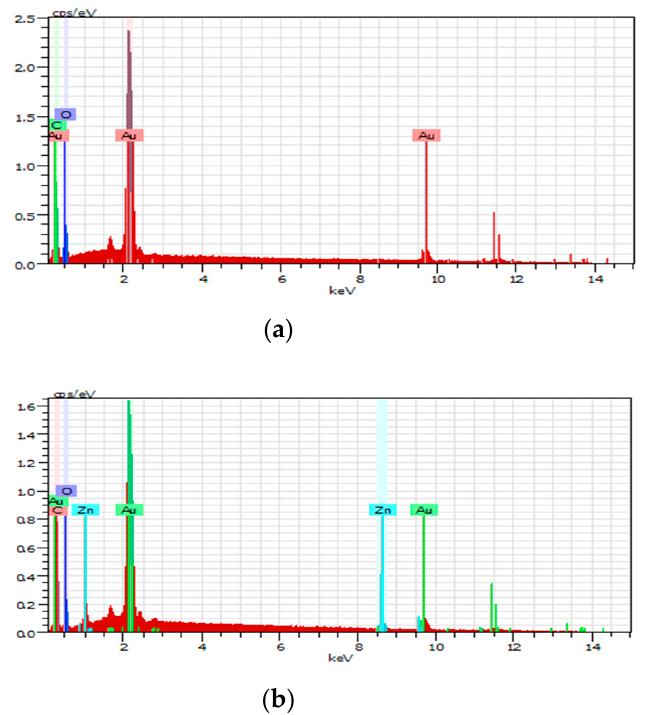
Figure 6. EDX spectra of the ( a ) pristine wood flour and ( b ) as-prepared superhydrophobic / superoleophilic wood